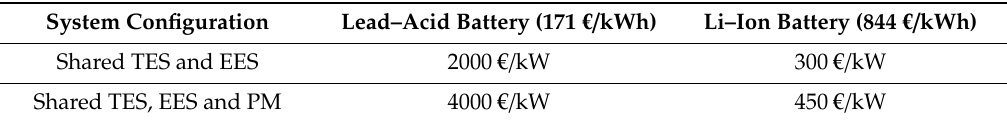
Table 7. Trade-o ff value of the investment cost of the